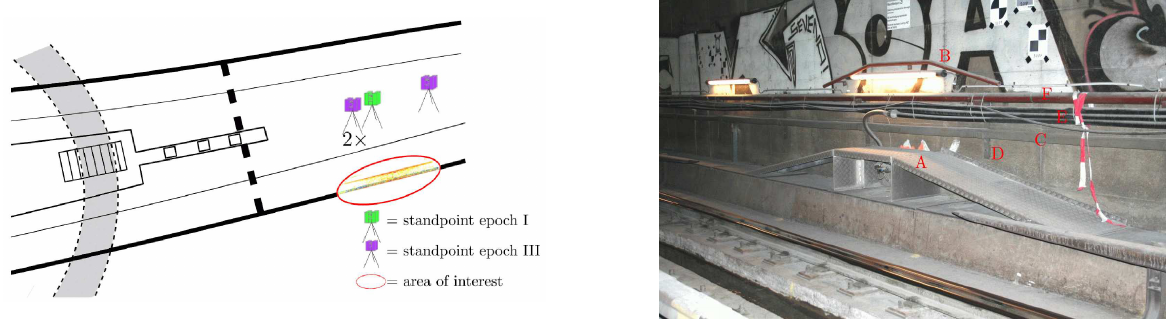
Figure 3: Left: Schematic representation of scanner standpoints in both epochs and area of interest. Right: Photograph of the footbridge taken in January 2010.